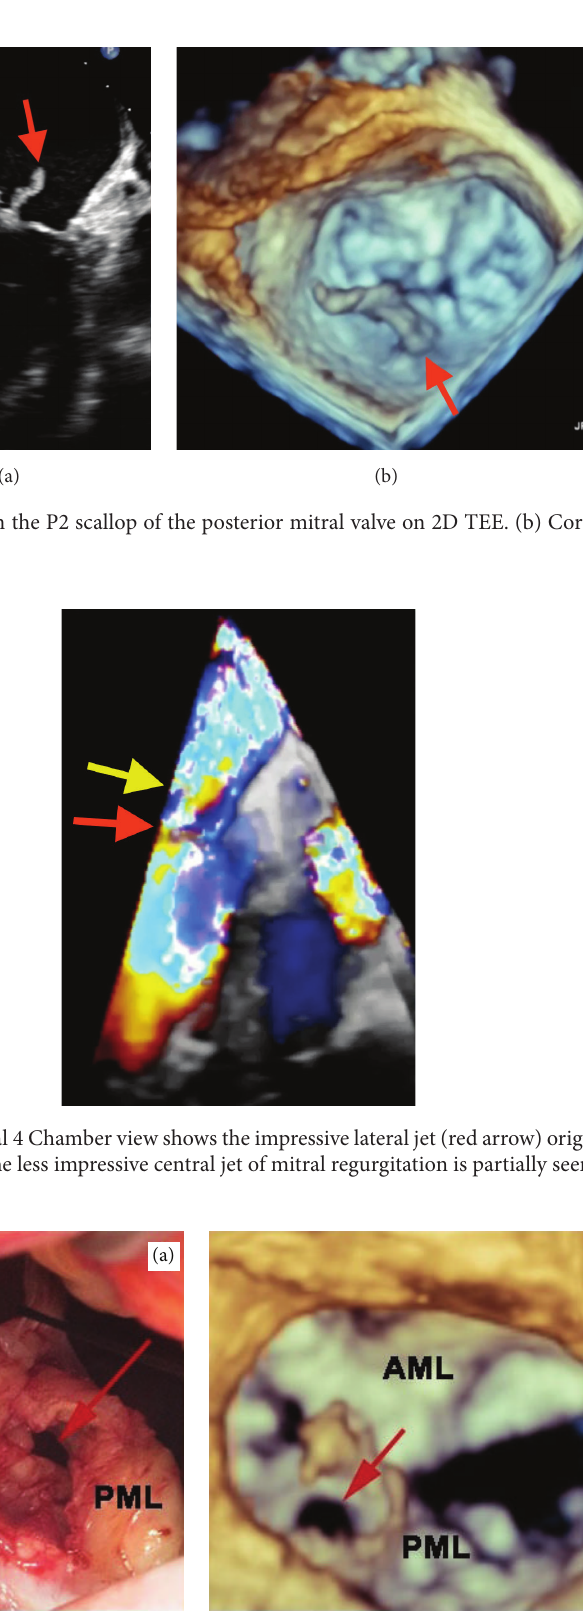
Figure 3: The red arrows on RT-3DTEE (a) and intraoperative image of the mitral valve (b) showing the perforation in the P2 scallop of the posterior mitral leaflet (AML: anterior mitral leaflet; PML: posterior mitral